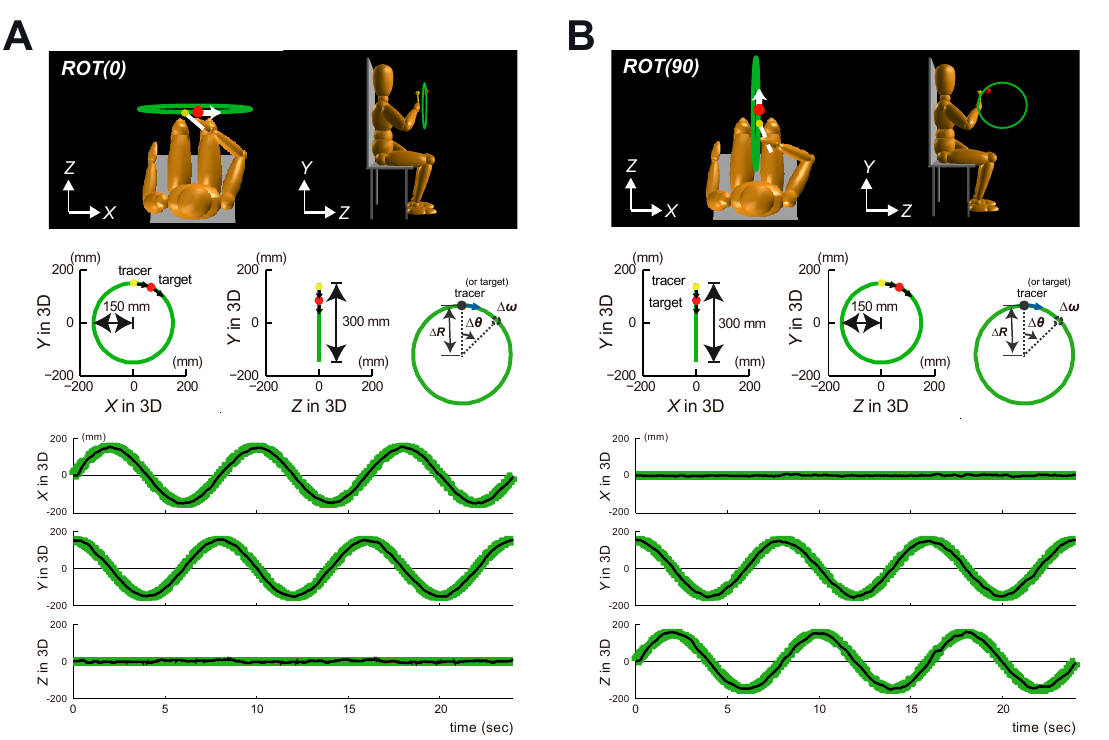
Figure 1. Experimental procedure. ( A ) The circular tracking experiment for the body’s frontal plane ( ROT (0)). ( B ) The circular tracking experiment for the body’s sagittal plane ( ROT (90)). For both ( A ) and ( B ), the top inset illustrates the circular tracking movement on each plane of the body in VR 3D space.